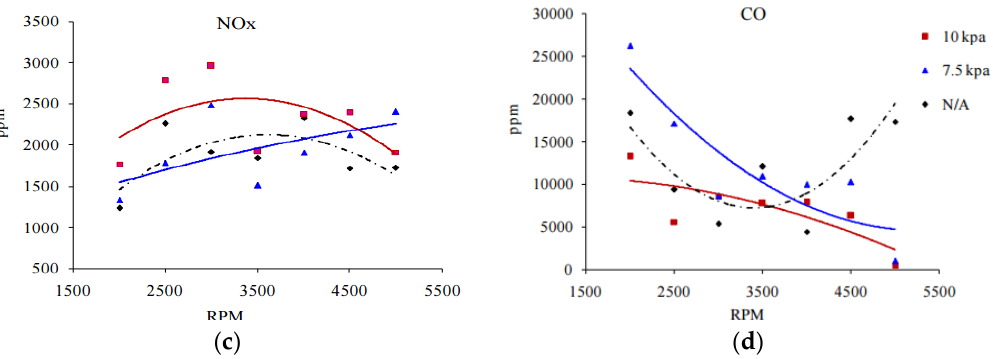
Figure 19. Performance (brake torque ( a ) and brake power ( b )) and emissions (nitrogen oxides (NOx) ( c ) and CO ( d )) of a CNG spark-ignition direct-injection (SIDI) engine at lower boost pressure [92].